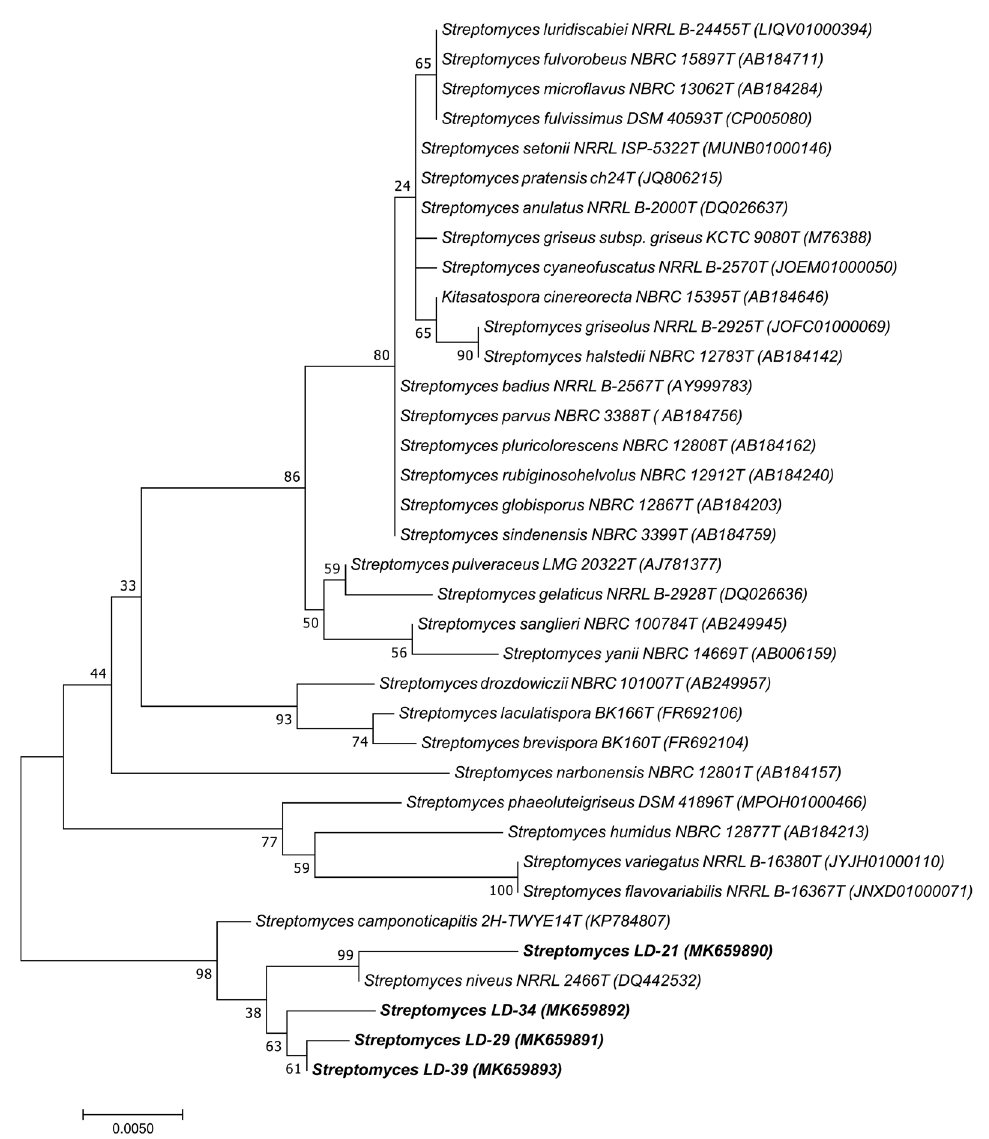
Fig.4. Maximum Likelihood Tree of the bioactive isolates (boldfaced) Streptomyces LD-21, Streptomyces LD-29, Streptomyces LD-34 and Streptomyces LD-39 along with related type strains based on 16S rDNA sequence. (Alpha-numeric characters within parenthesis are GenBank accession numbers of the corresponding strains. The numbers at the nodes are bootstrap percentages based on 1000 replicates. Horizontal bar equals 0.5% sequence